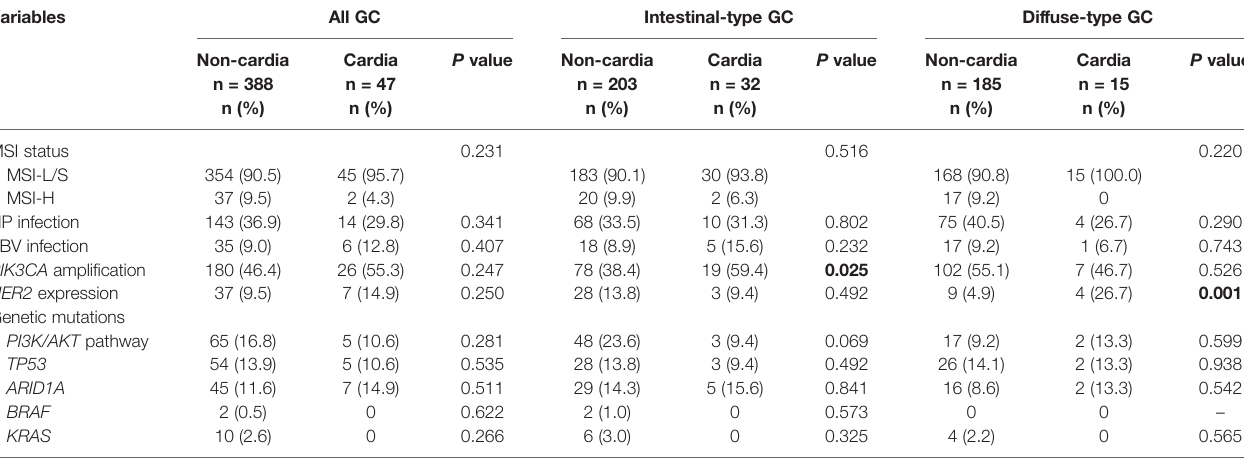
TABLE 5 | The molecular differences between cardia and non-cardia GC patients after curative surgery.